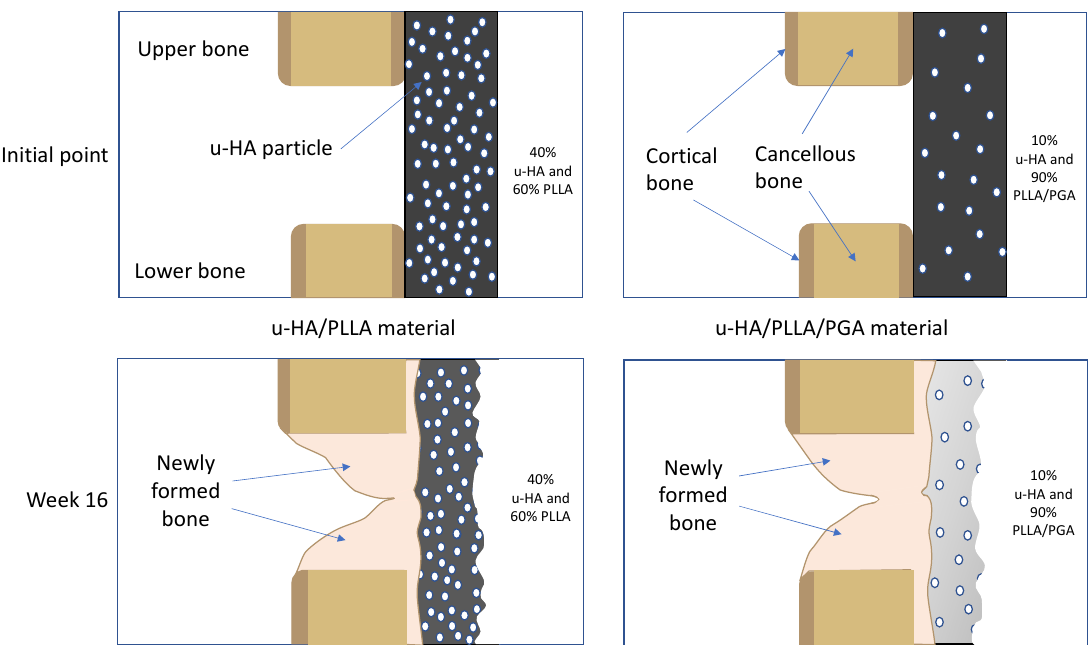
Figure 17. Theoretical explanation of the relationships between the bone remodeling capacity of u-HA/PLLA/PGA material and the u-HA particle proportion and degradation rate. Because of the more rapid degradation process, the u-HA particles in the new nanomaterial may be exposed to body fluids at an earlier stage.